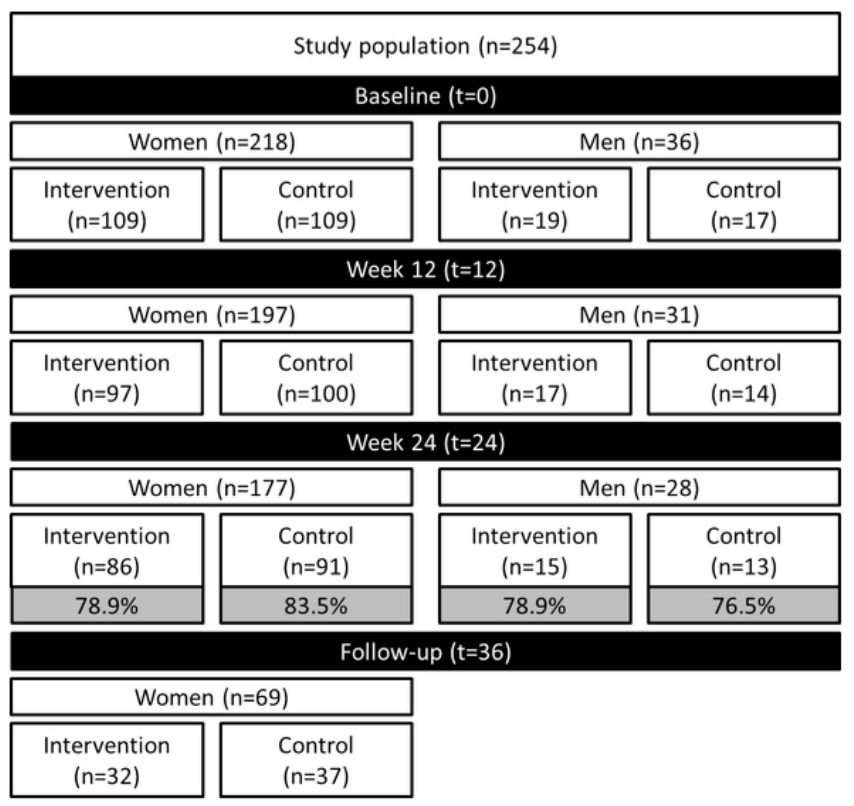
Figure 1. Flowchart of the study population stratified by